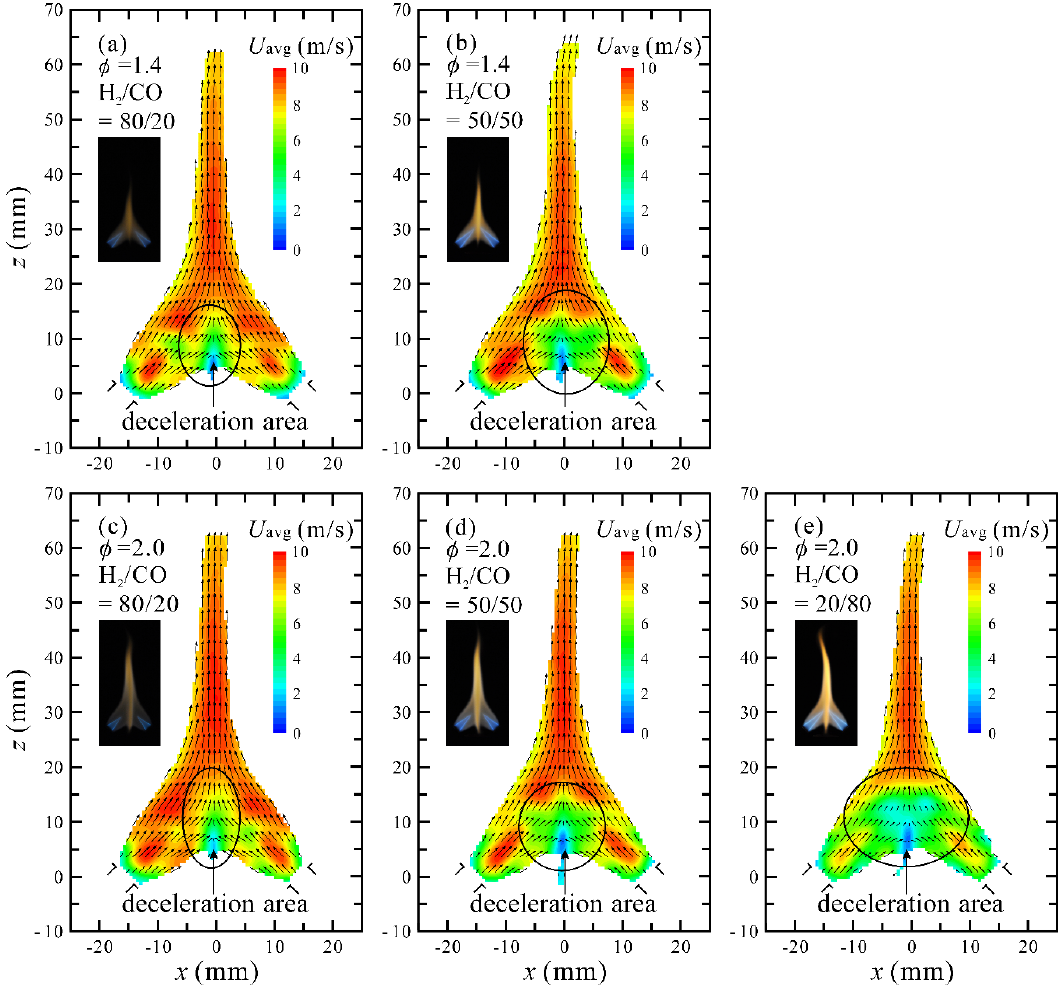
Figure 7. Velocity distributions of CH 4 /syngas/air premixed impinging flames: ( a ) φ = 1.4 and H 2 /CO = 80/20; ( b ) φ = 1.4 and H 2 /CO = 50/50; ( c ) φ = 2.0 and H 2 /CO = 80/20; ( d ) φ = 2.0 and H 2 /CO = 50/50; ( e ) φ = 2.0 and H 2 /CO = 20/80.